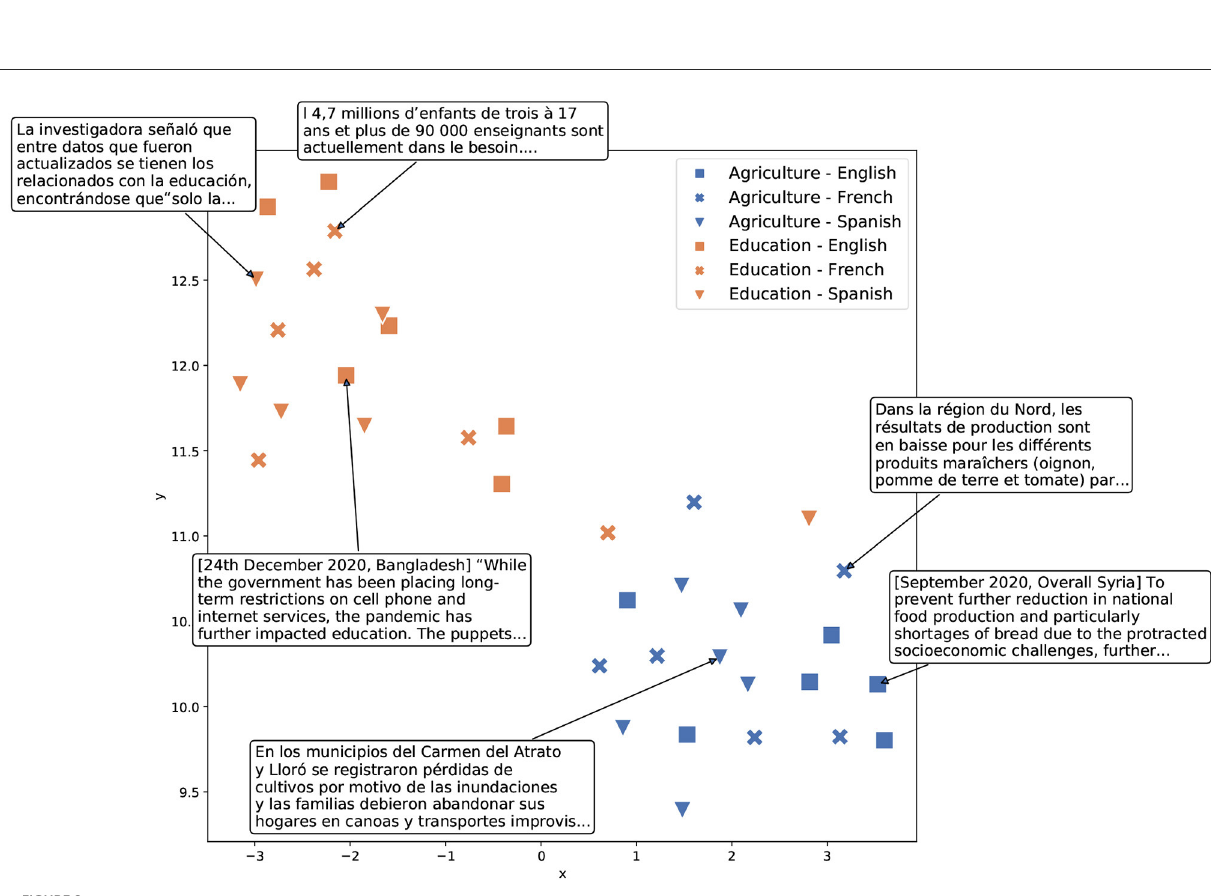
FIGURE2 Vector representations of sample text excerpts in three languages created by the USE model, a multilingual transformer model, (Yang et al., 2020) and projected into two dimensions using TSNE (van der Maaten and Hinton, 2008). Text excerpts are extracted from a recent humanitarian response dataset ( HUMSET , Fekih et al., 2022; see Section 5 for details). As shown, the language model correctly separates the text excerpts about various topics (Agriculture vs. Education), while the excerpts on the same topic but in different languages appear in close proximity to each